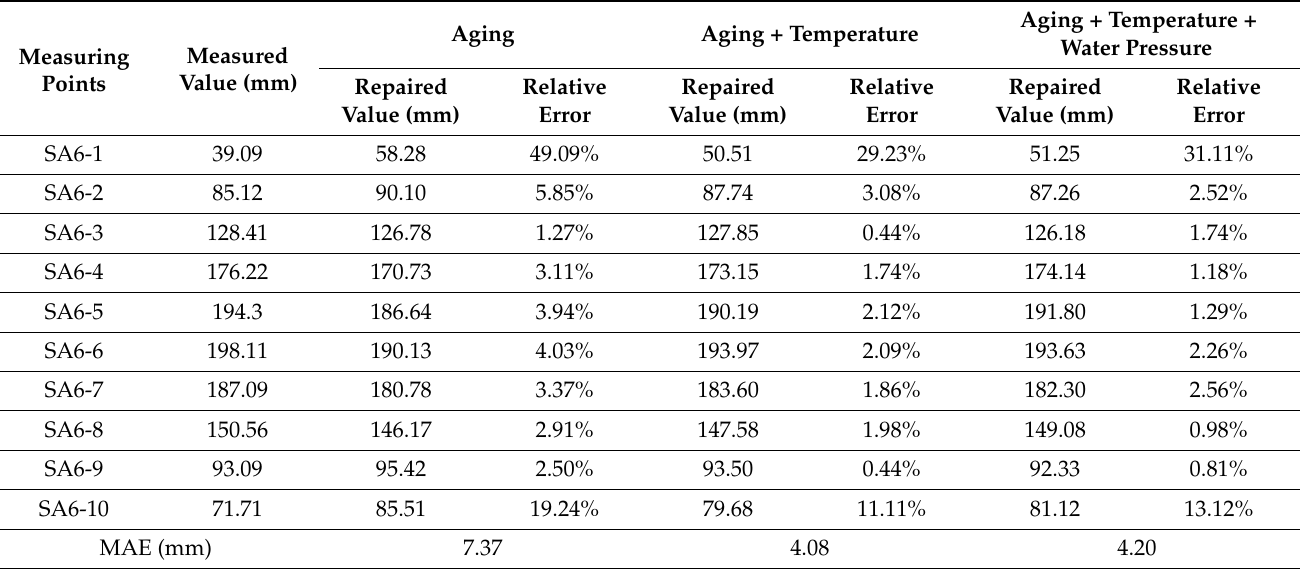
Table 1. Spatial repair results with selection of different covariates of the one-dimensional